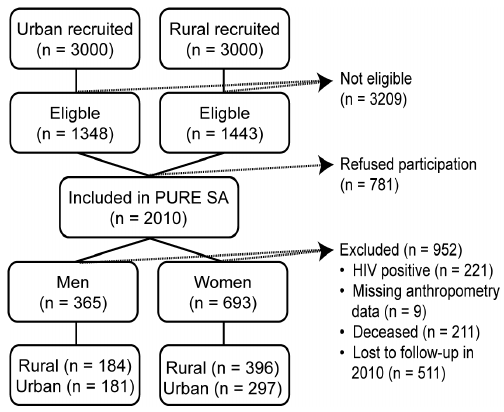
Figure 1. Consort diagram of the Prospective Urban and Rural Epidemiology (PURE) study reported herein.